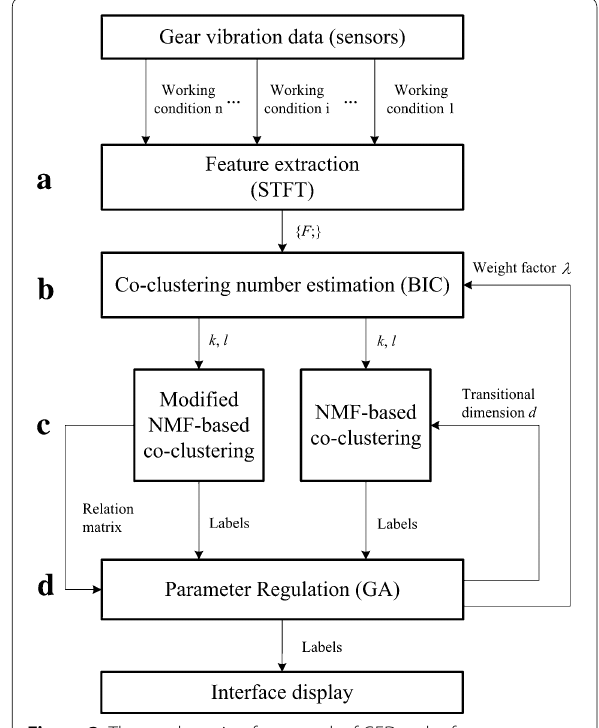
Figure 3 The co-clustering framework of GFD: a the feature extraction sub-frame; b the clustering number estimation sub-frame; c the co-clustering sub-frame; d the parameter regulation